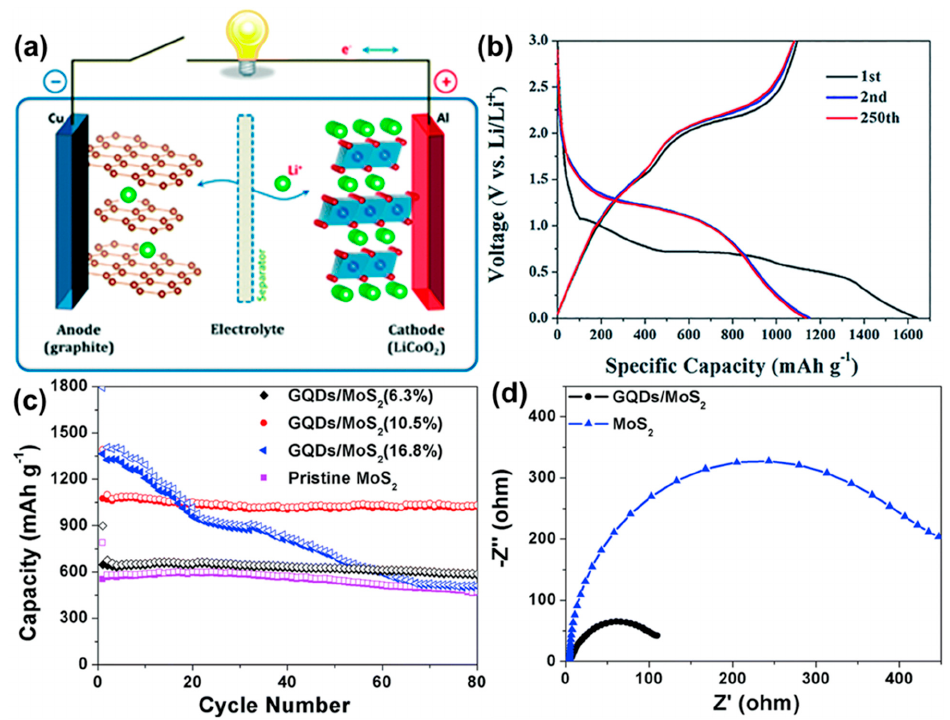
Figure 16. ( a ) Schematic representation of a LIB working principle. Reprinted with permission from Ref. [139]. ( b ) Charging-discharging profiles in different cycles of the NiO@Co3O4@GQDs electrode in LIB. Reprinted with permission from Ref. [130]. ( c ) Effect of GQDs concentration on the cyclic performance of LIB electrode. ( d ) EIS spectra. Reprinted with permission from Ref. [131].